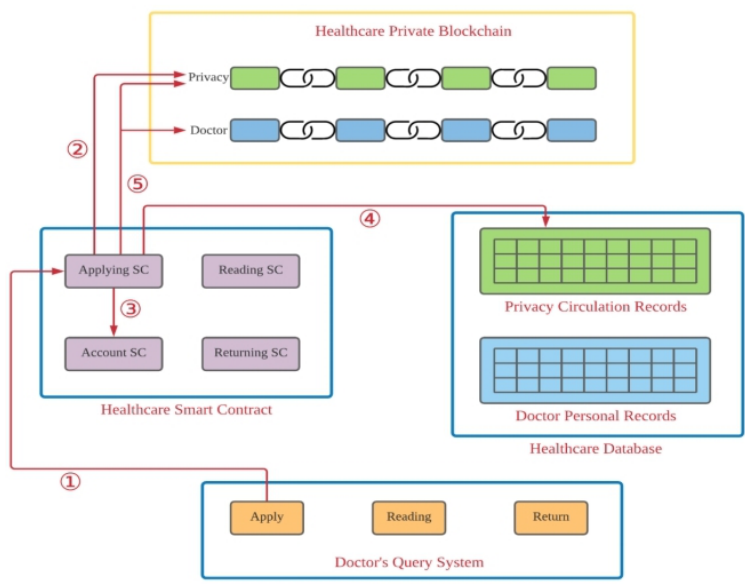
Figure 1. Data flow of the proposed healthcare application subsystem.